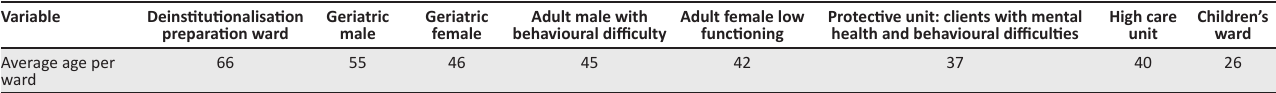
TABLE 2: Average chronological age of the sample ( n = 568) for different wards. Variable